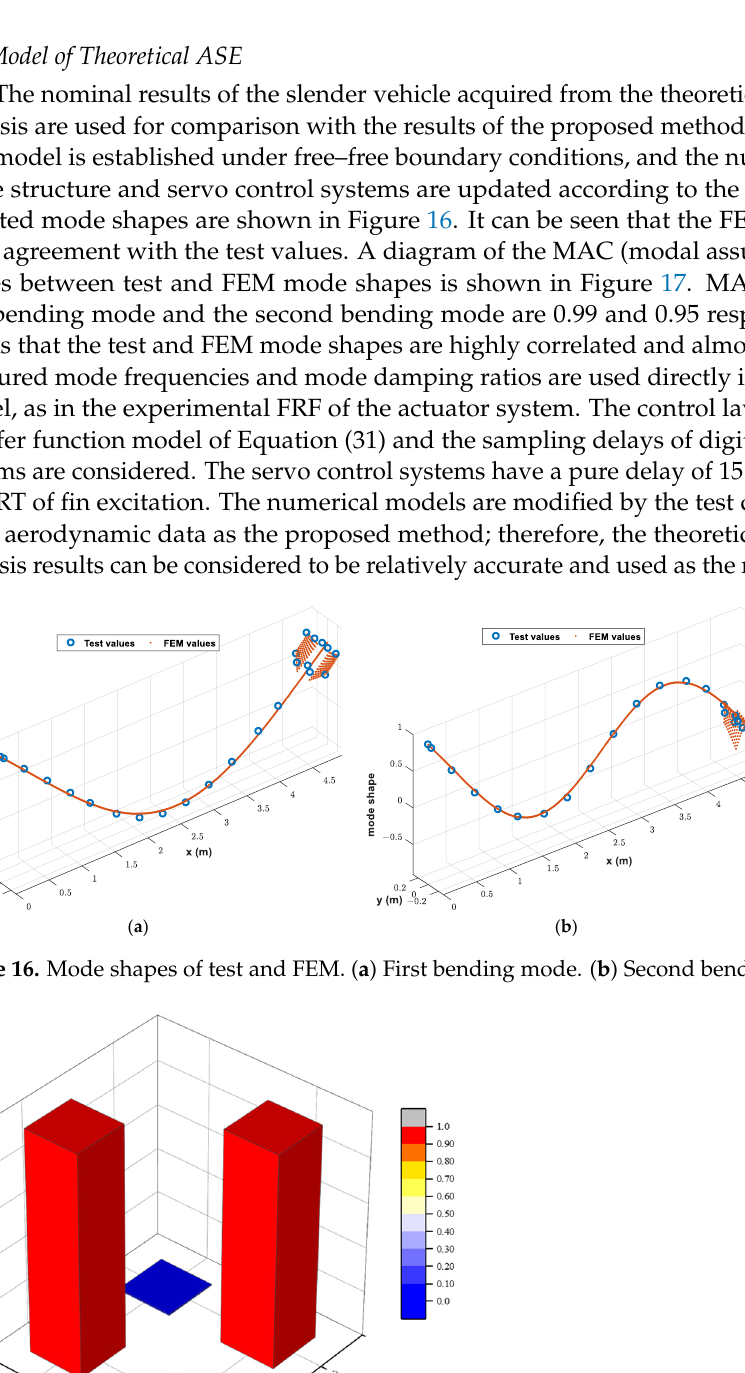
Figure 17. MAC value between test and FEM mode shapes.